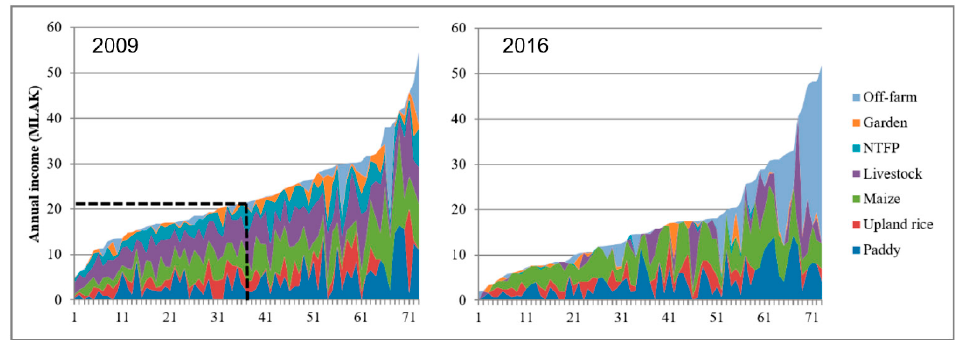
Figure 7. Income composition of the same 73 households surveyed in 2009 and 2016. Off-farm activities developed as main diversification option for both the better-off farmers who were eager to reinvest their maize-earned capital, and for worse-off farm- ers who searched for employment with the former or migrated as strategies of distress diversification. Off-farm activities played a key role as economic buffers in times of risky innovation (Figure 7). Some farmers invested the capital they earned from maize in trading activities or opening a grocery in the village as an additional source of more regular income. The poorer households have had to work for others or move to other villages in search of seasonal agricultural work as a flexible cash earning option. Over our study period, the percentage of households working for someone else increased from 30% to 60% of the community, while the percentage of households who were rice sufficient for more than 6 months dropped from 70% to